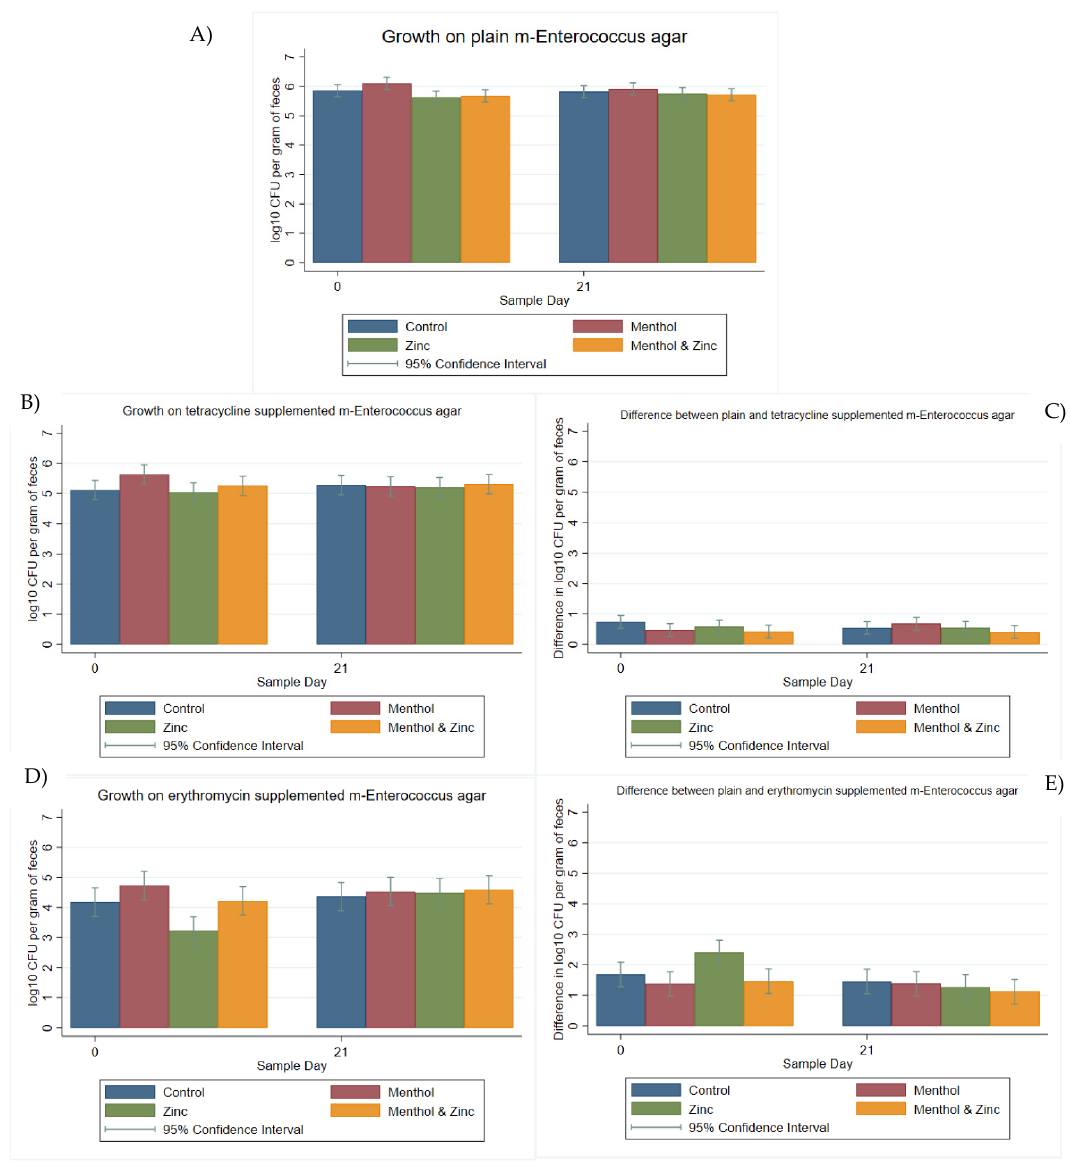
Figure 2. Marginal means with 95% confidence intervals of a 2 × 2 × 2 multi-level mixed linear regression model, using factors of zinc, menthol and sample day. ( A ) log 10 CFU per gram of feces on plain m- Enterococcus agar, ( B ) log 10 CFU per gram of feces on tetracycline-supplemented m- Enterococcus agar, ( C ) Difference in log 10 CFU between plain and tetracycline-supplemented m- Enterococcus agar, ( D ) log 10 CFU per gram of feces on erythromycin-supplemented m- Enterococcus agar and ( E ) Difference in log 10 CFU between plain and erythromycin-supplemented m- Enterococcus agar.